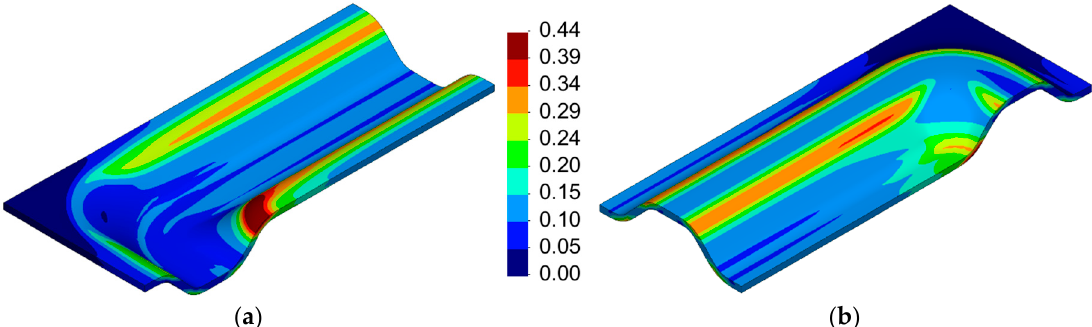
Figure 24. Equivalent plastic strain distribution plotted on the deformed configuration of the channel parameters considering w 1 = 1.4 mm, s = 1.6 mm, r = 0.4 mm, R = 0.5 mm, and h = 0.7 mm: ( a ) upper surface of the flow channel; ( b ) lower surface of the flow channel.